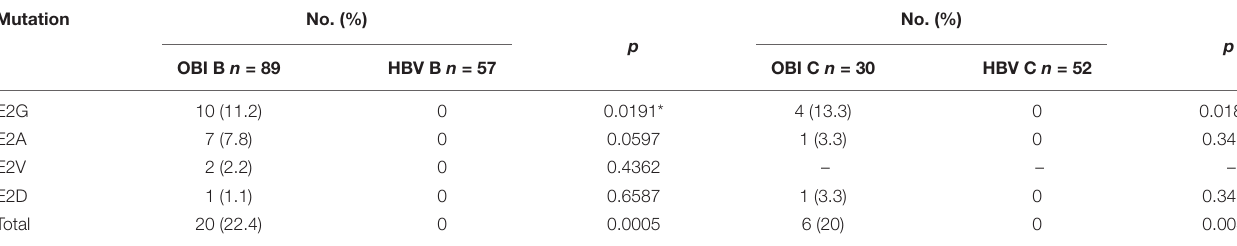
TABLE 1 | E2 mutations in OBI and control group.